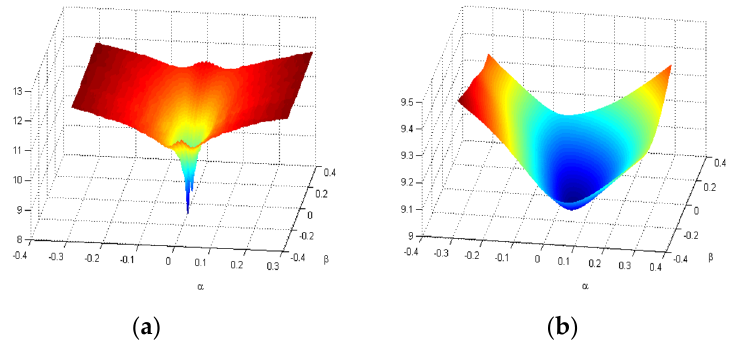
Figure 4. Cost surface of image entropy. ( a ) Cost surface via conventional image entropy. ( b ) Cost surface via image entropy combined with subarray averaging.